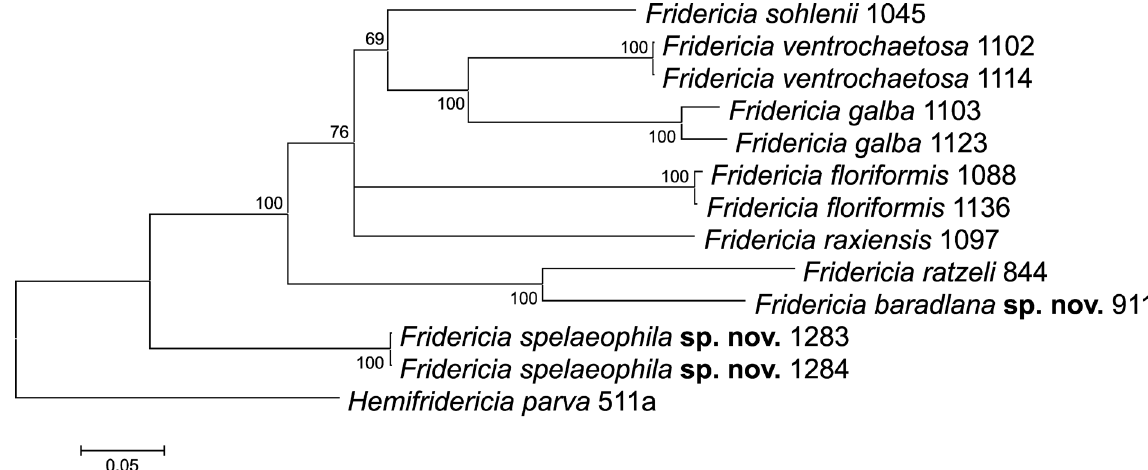
Fig. 7. Concatenated phylogenetic tree of the two new and other Fridericia species based on 1447 nucleotid positions (which comprise the CO1, H3 genes and the ITS region). Posterior probabilities greater than 50 are shown at the nodes. Sequences from new species described here appear in